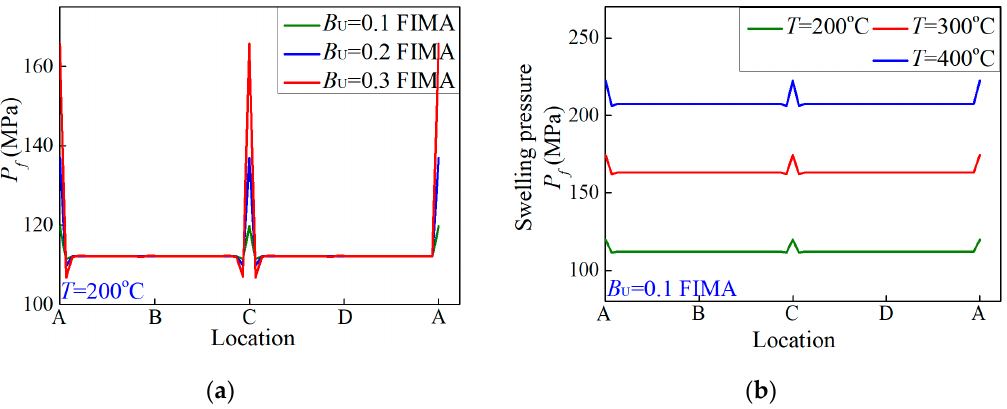
Figure 5. The distributions of irradiation swelling pressures exerted on the matrix interface Γ when there were two symmetric fission pores under ( a ) different burnup and ( b ) different